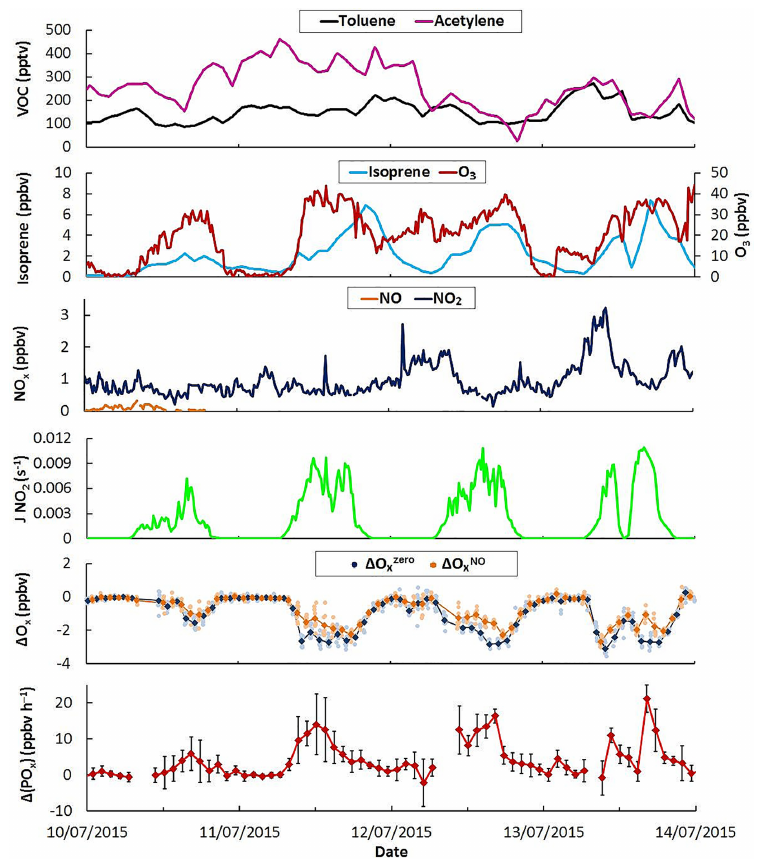
Figure 8. Time series of selected trace gases, J (NO 2 ) , measured (cid:49) O x and (cid:49)P (O x ) values during 4 days of the IRRONIC campaign when 6ppbv of NO was intermittently added in the flow tubes. The light colors on (cid:49) O x correspond to 2min measurements while the darker colors are 20min averaged values. Error bars on (cid:49)P (O x ) are 1 σ on the averaged 20min